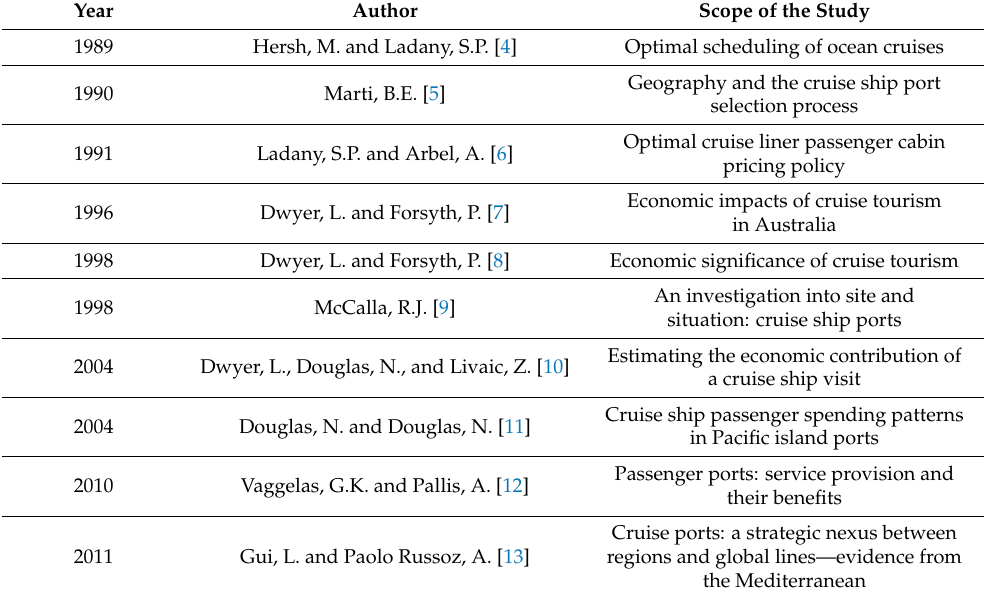
Table 1. Research in the field of cruise